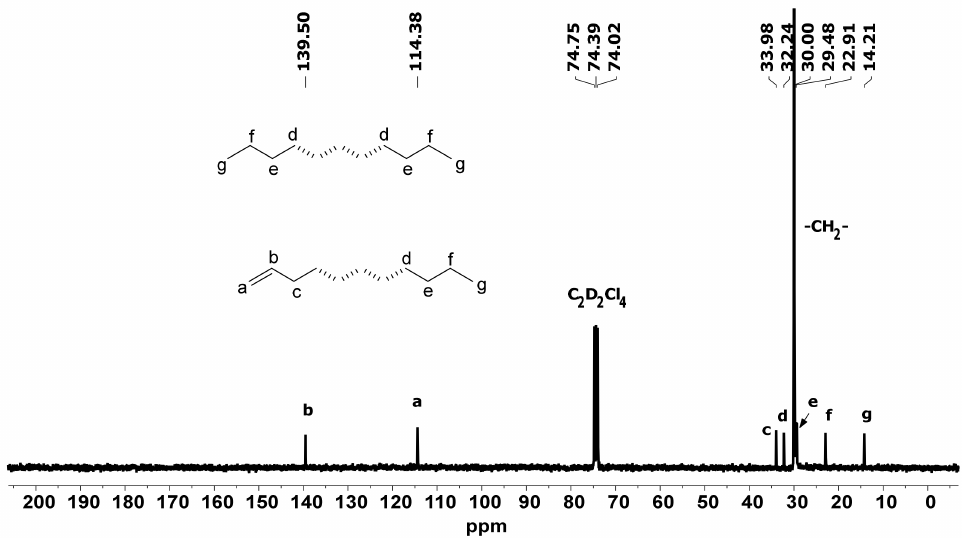
Figure 12. The 13 C-NMR spectrum of the polyethylene obtained with Co1 /MMAO (Table 3, entry